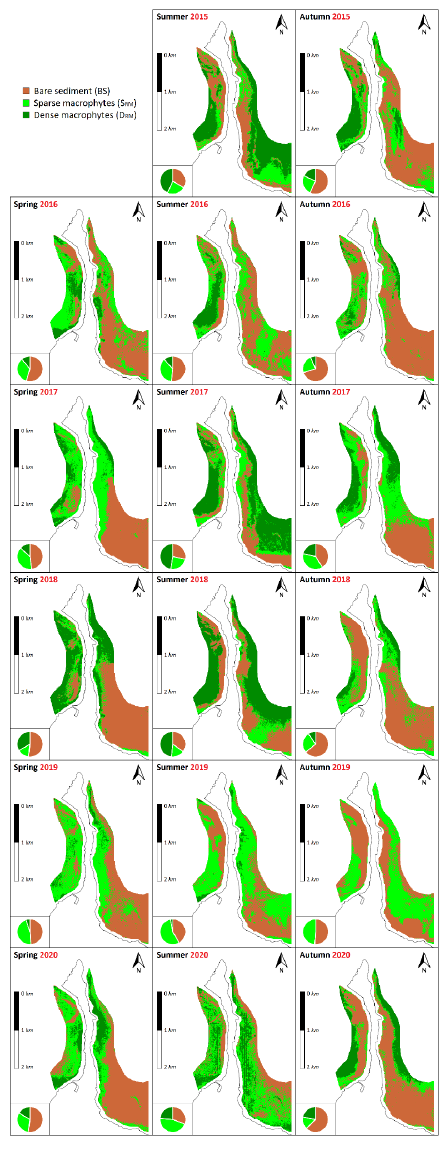
Figure 2. Seasonal spatial distribution of the classes of bottom cover from 2015 to 2020: bare sedi- ment (BS, brown), sparse macrophytes (S RM , light green), and dense macrophytes (D RM , dark green).